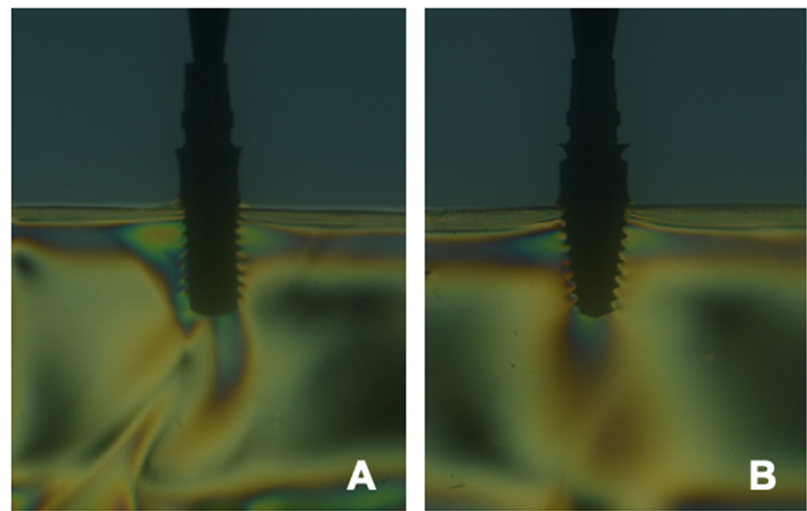
Figure 15. Tension fringes after loading onto abutment/implant. Legend: ( A ) Two-piece zirconia abutment/implant (Straumann PURE Two-Piece Ceramic Implant, Bone Level, Straumann Dental System Implant, Basel, Switzerland); ( B ) Two-piece titanium abutment/implant (Straumann BLT Implant, Bone Level, Straumann Dental System Implant, Basel, Switzerland).